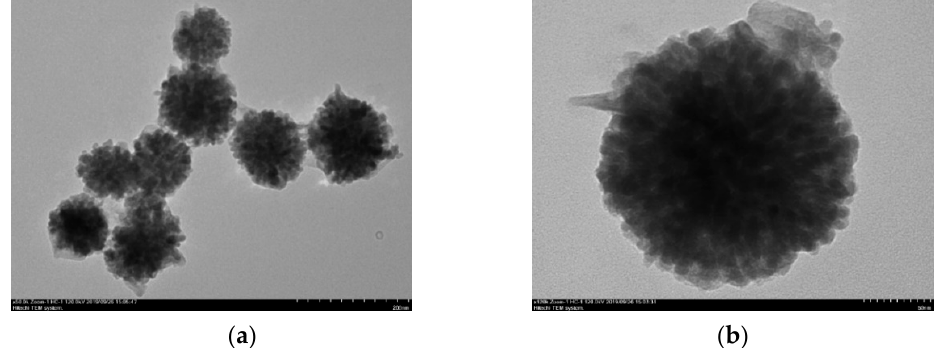
Figure 3. TEM images of CoFe 2 O 4 @SiO 2 nanostructures ( a ) and of one isolated nanoparticle( b ).